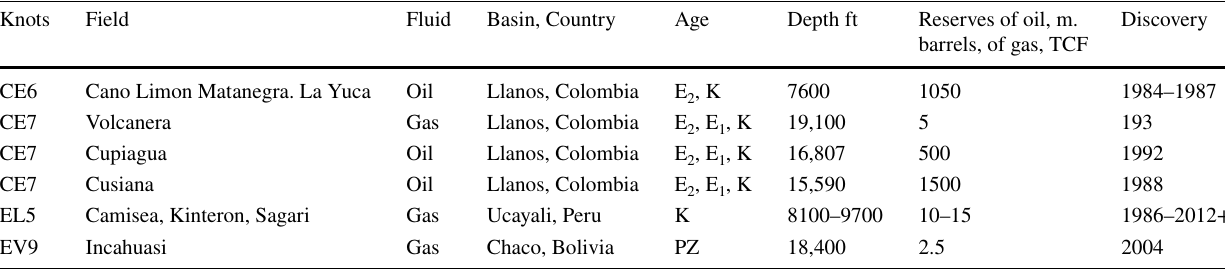
Table 1 Oil and gas fields discovered after publication of the prediction 1986 Knots